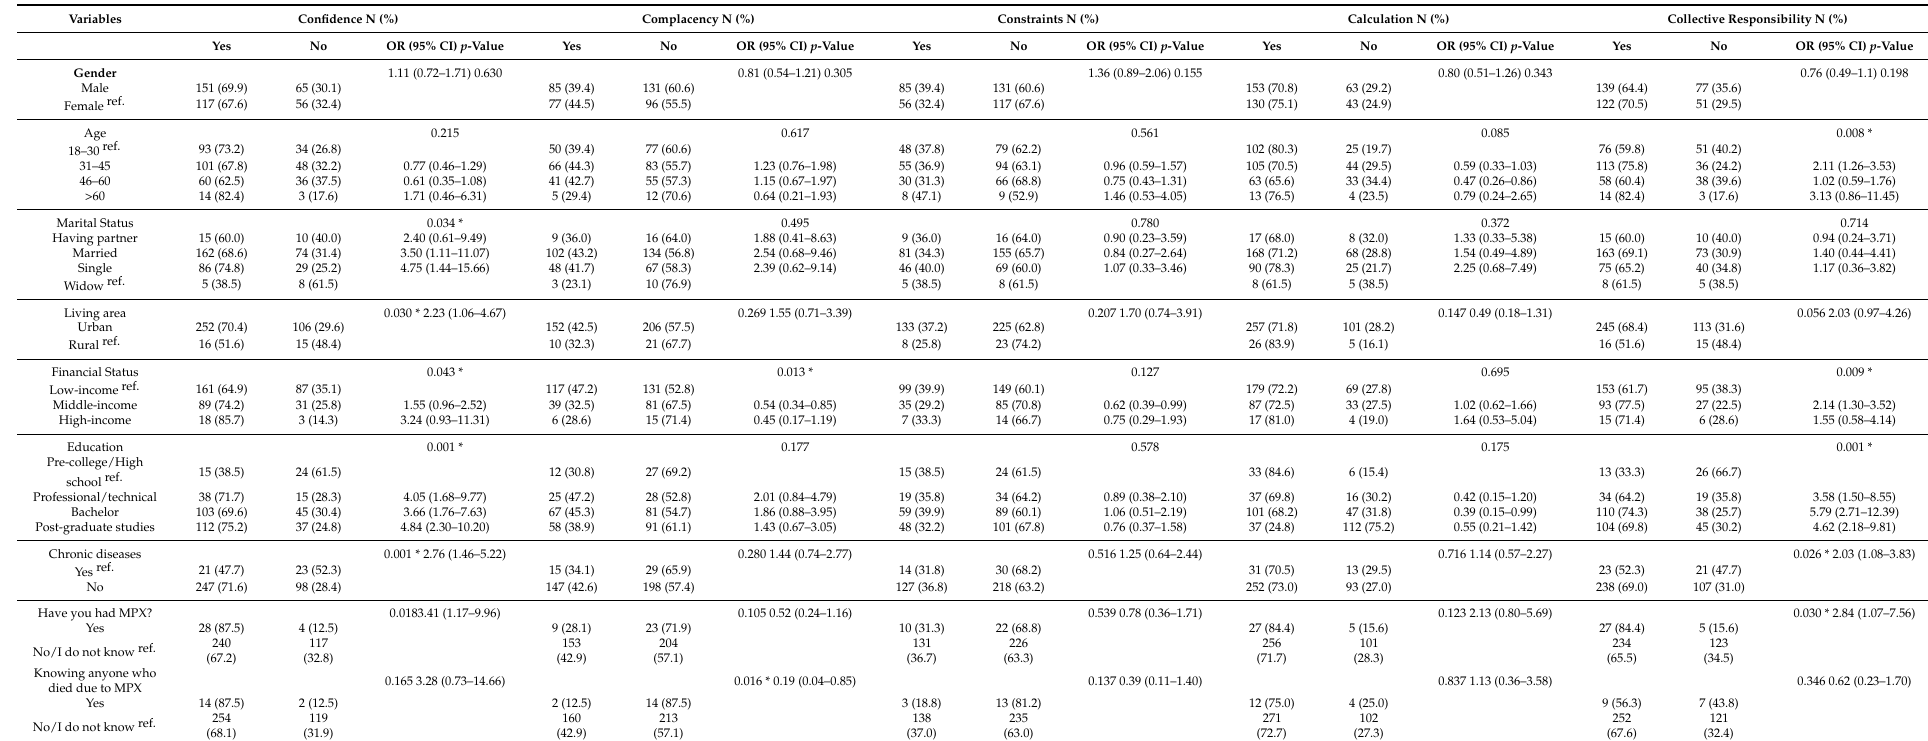
Table 2. The 5C scale domains across different variables among the sample of Nigerian